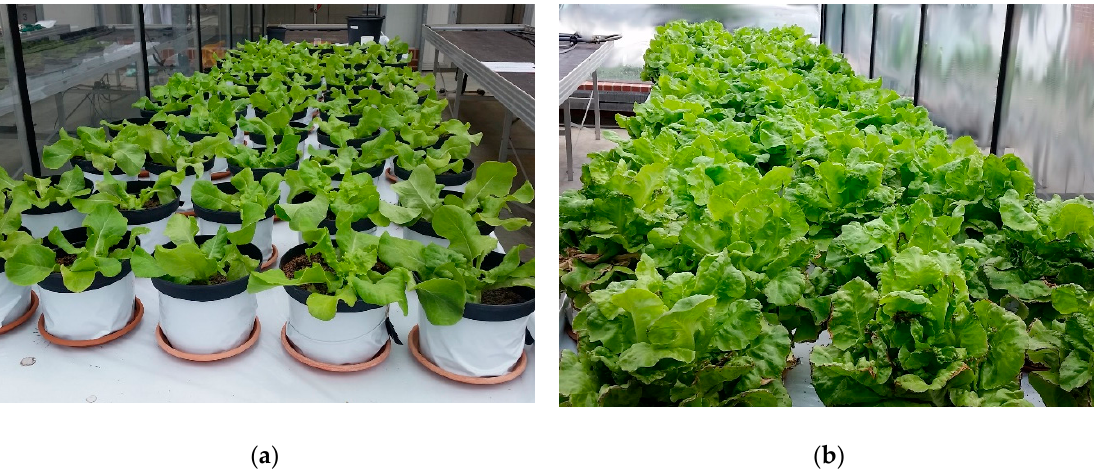
Figure A1. Evapotranspiration of the lettuce plants and climate chamber temperature data. The lower y -axis shows the evapotranspiration of the treatments in g per plant and day for the different treatments (measured and interpolated). The upper y -axis shows the temperature [°C] in the climate chamber during the experiment. The lower and upper lines indicate the daily minimum and the daily maximum temperature. The middle line indicates the daily mean temperature. The average air temperature during the whole experimental period was 26.6 °C at day and 20.7 °C at night, and the average relative humidity was 57.9%.